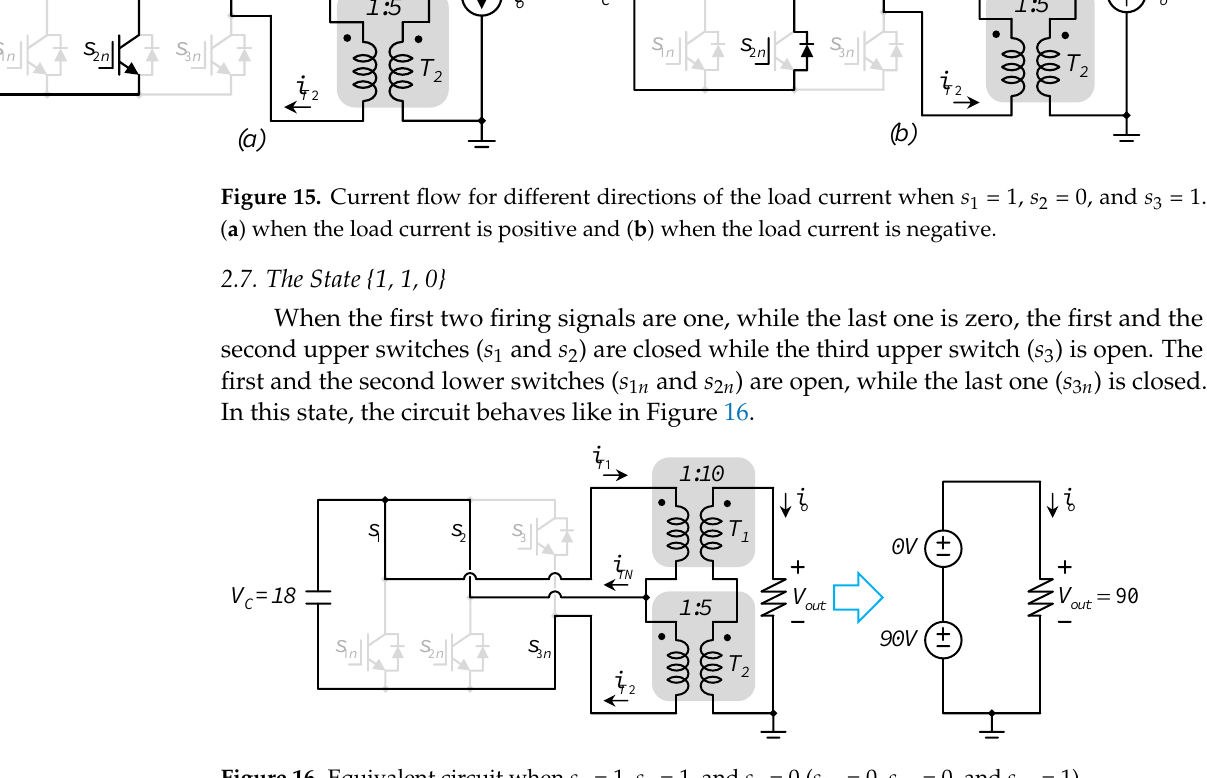
Figure 17. Current flow for different directions of the load current when s 1 = 1, s 2 = 1, and s 3 = 0. (a) when the load current is positive and (b) when the load current is negative.